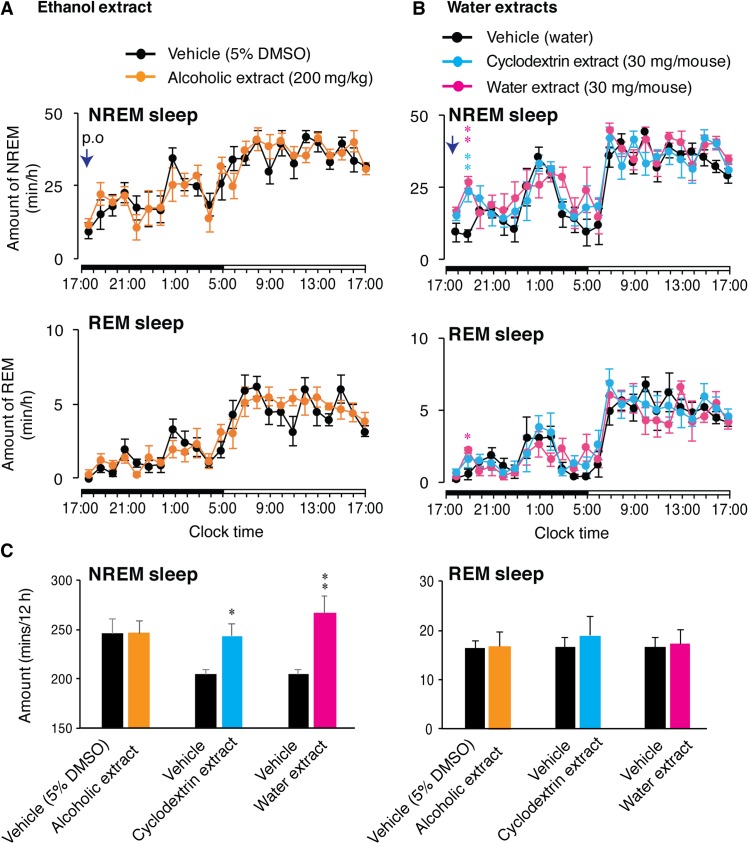
Oral administration of various extracts from Ashwagandha leaves in mice and their effect on sleep-wakefulness.(A) Hourly plots of NREM and REM sleep after p.o. administration of vehicle (black circles) or alcoholic extract of Ashwagandha leaves (orange circles; n = 5). (B) Hourly plots of NREM and REM sleep after p.o. administration of vehicle (black circles) or water extracts of Ashwagandha leaves; cyclodextrin extract (blue circle) and water extract (magenta circles; n = 6). Arrows indicate time of p.o. administration. Black and white horizontal bars indicate 12 h dark and 12 h light period. (C) Changes in total amount of NREM (left graph) and REM sleep (right graph) during dark phase after p.o. administration of vehicle (black bars) and various Ashwagandha leaf extracts (colored bars). All administrations were done at the onset of dark period (17:00 h). Data presented as mean ± SEM; *p≤0.05, **p≤0.01 vs vehicle by using paired t-test.